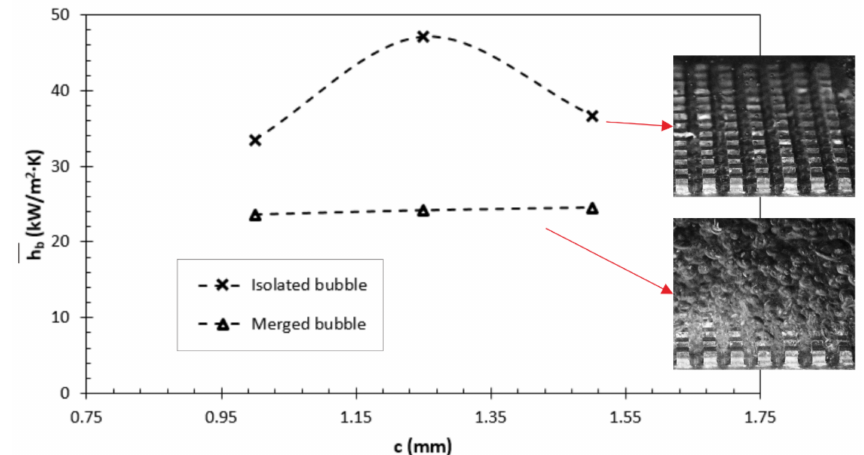
Figure 9. Boiling heat transfer coefficient in different fin gaps from rectangular pin fin